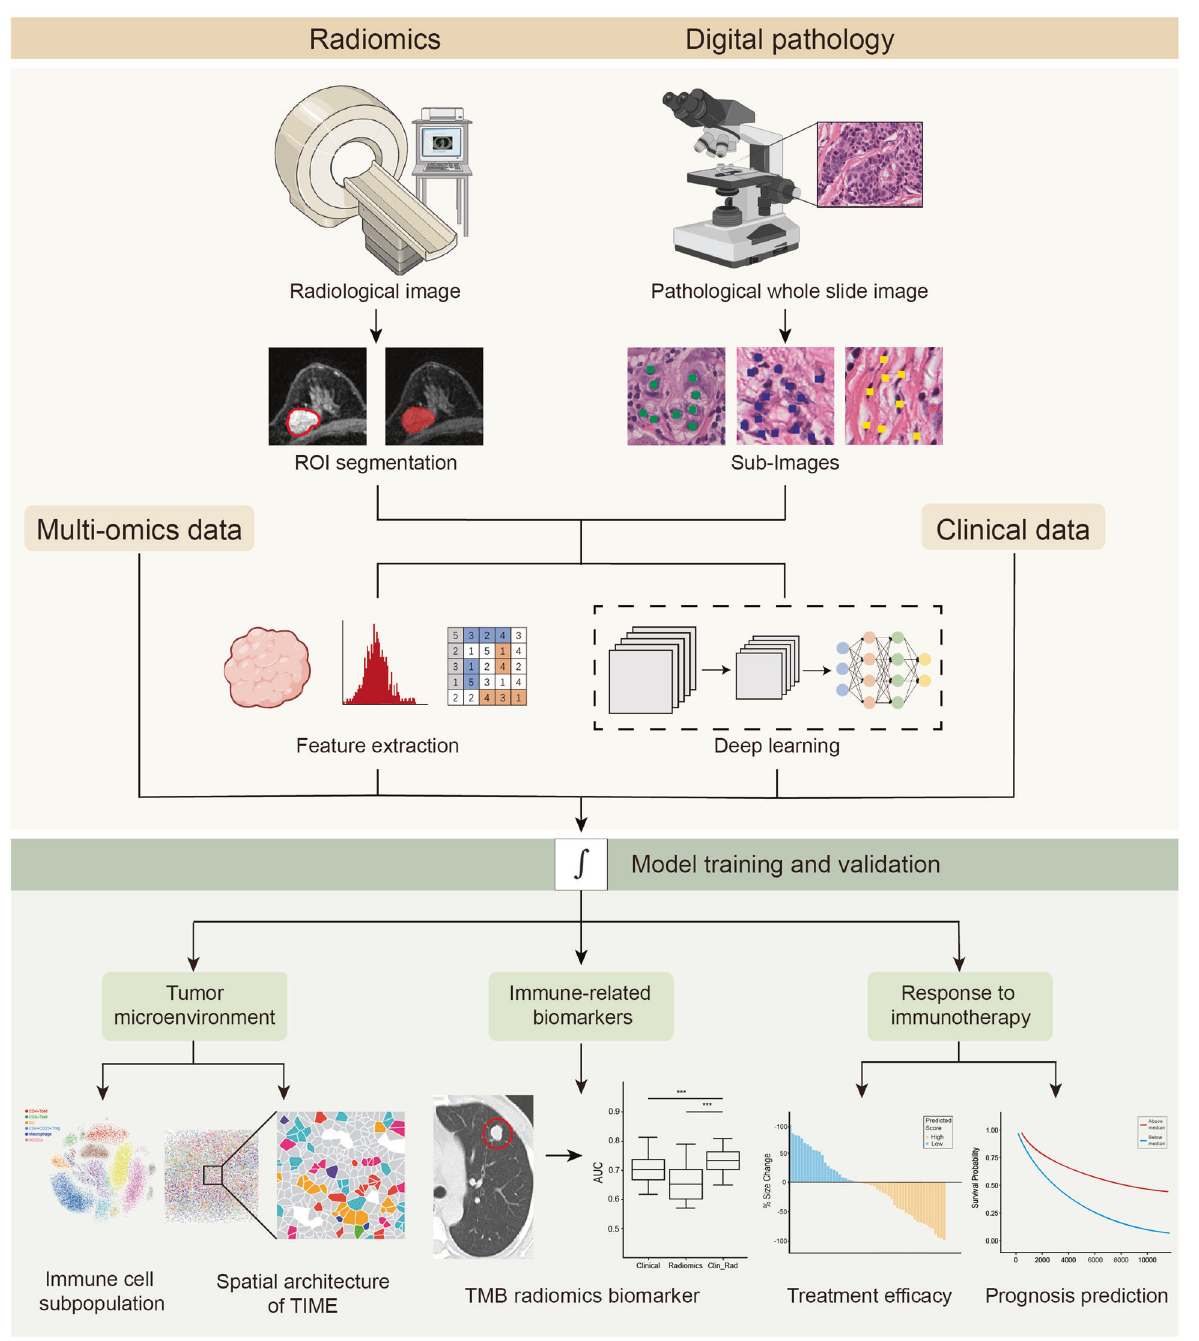
Fig. 3 Radiomics and computational pathology in tumor immunity exploration. Radiological and pathological image-derived omics data enable the investigation of the tumor immune microenvironment (TIME) and response to immunotherapy. For a raw radiology image, regions of interest, generally representing the tumor lesion area, are segmented, while a pathological image is divided into numerous sub-images. Two methods can be applied to analyze these high-dimensional data. First, features, including but not limited to statistical features, tumor volume features, and texture features, are extracted and analyzed by professional clinicians. Alternatively, images are input into a convolutional neural network (CNN). After a complicated deep learning process, robust models are output. These radiomics or digital pathologic models could fi nally be established to evaluate or predict the immune index, which can be divided into three aspects. First, TIME dissection encompasses distinct immune cell subset classi fi cation and TIME spatial architecture characterization, resembling single-cell technologies and CODEX, respectively. Second, immune-related biomarkers, such as the tumor mutation burden (TMB), could be predicted. Third, response to immunotherapy and clinical outcomes could be predicted. ROI regions of interest, TIME tumor immune